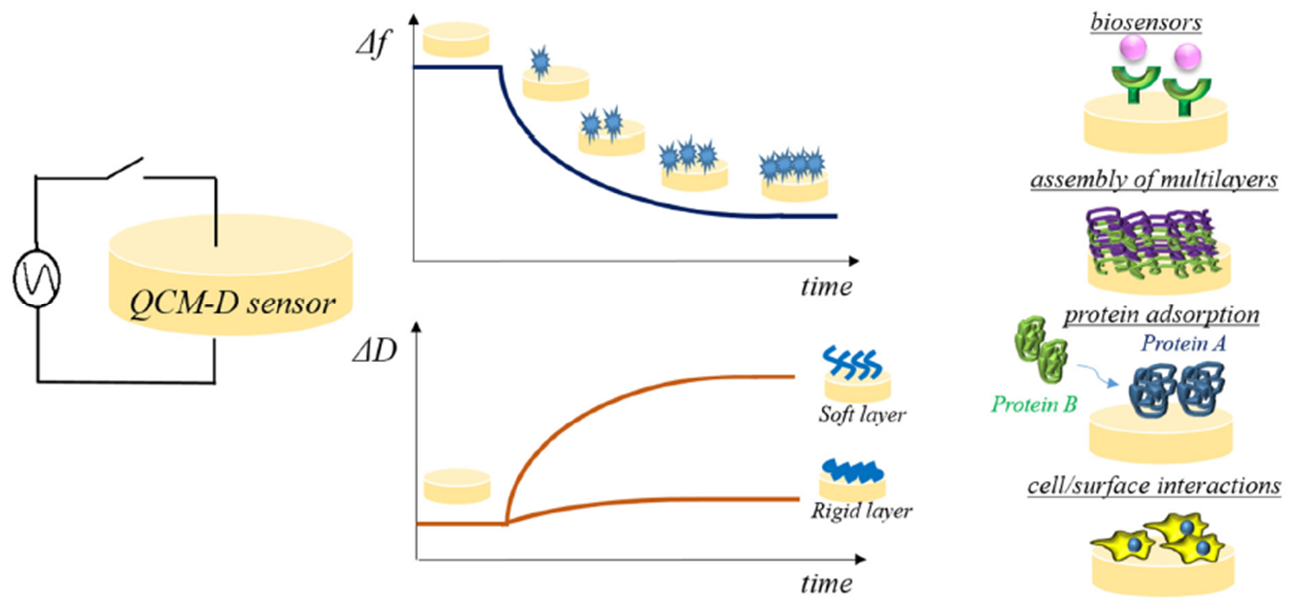
Figure 4. Experimental settings on QCM-D. Reproduced from [43] Creative Commons CC-BY license.